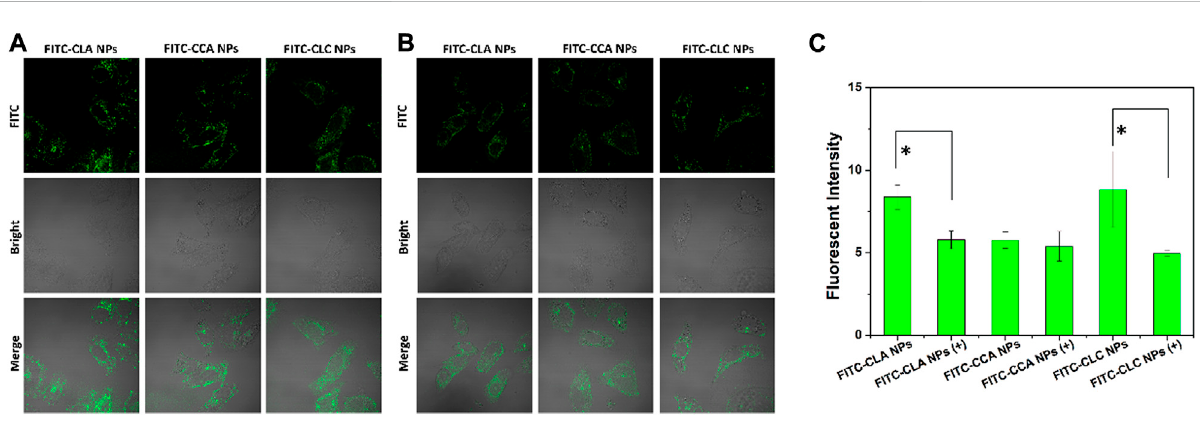
FIGURE 4 FITC-labeled nanoparticles co-incubated with HepG2 cells for 4 h (A) ; Incubate cells with free LA for 30 min to saturate the LA-receptor, and then co-incubate cells with FITC-labeled nanoparticles for 4 h (B) ; Quantitative analysis of the FITC fl uorescence intensity measured by ImageJ (C) , +means cells were pre-incubated with LA; * represents p < 0.05; ** represents p < 0.01.